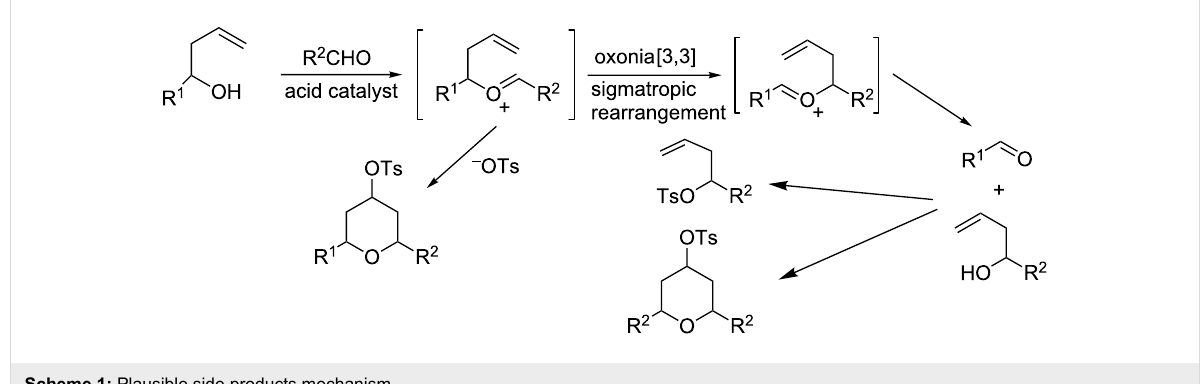
Scheme 1: Plausible side products mechanism.